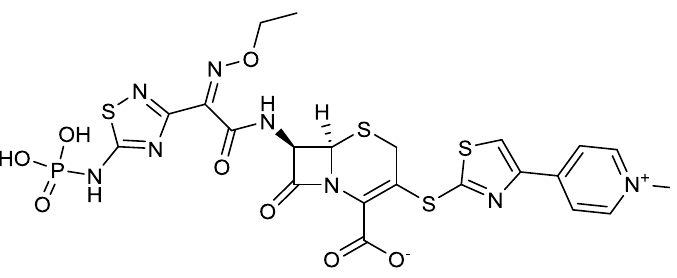
Figure 4. Chemical structure of ceftaroline